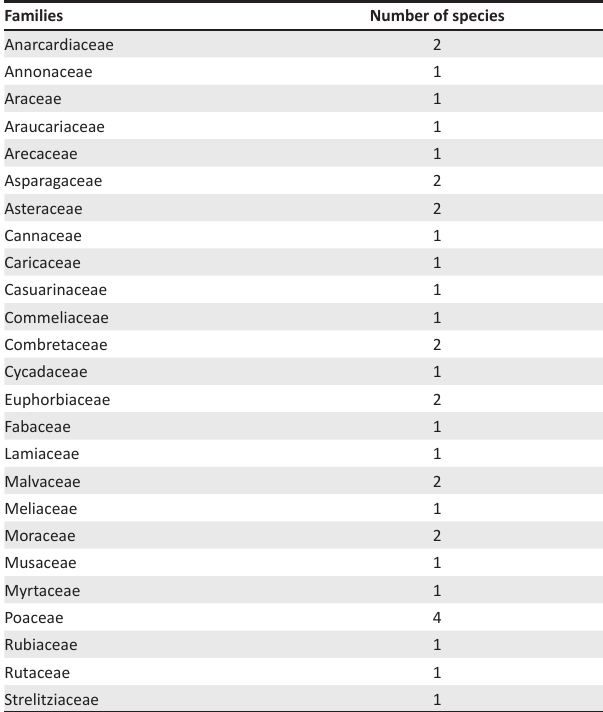
TABLE 4: Frequency of occurrence of plant species on Lagos State University campus.